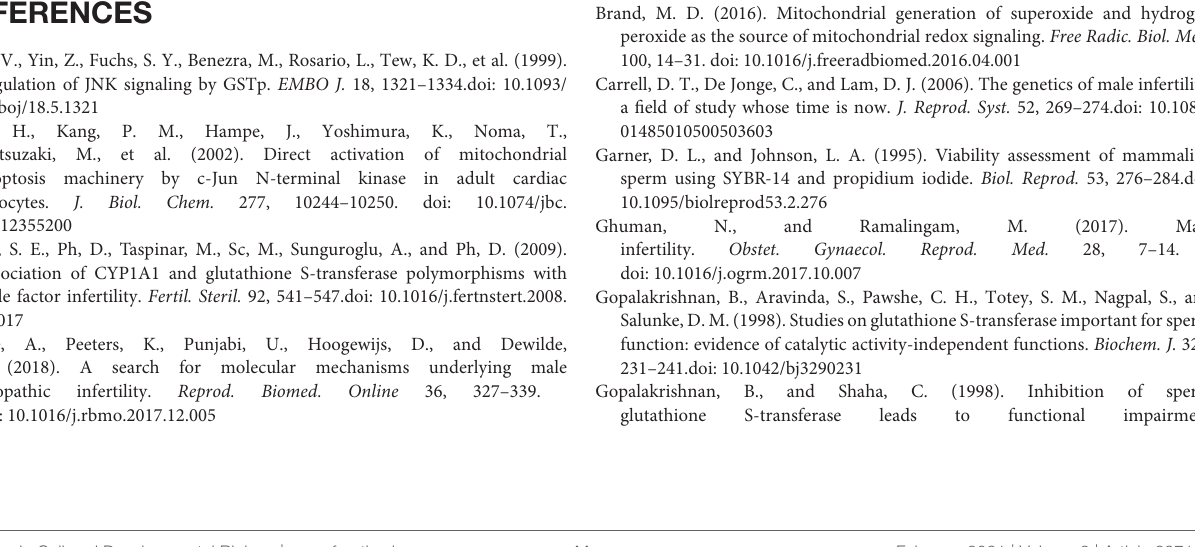
Supplementary Figure 1 | Preliminary concentration test. Mean and standard error of the mean (SEM) of the percentage of (A) viable sperm, (B) total motile sperm, (C) viable-membrane destabilized sperm,and (D) high mitochondrial membrane potential (high MMP) sperm. Different ezatiostat (TER) concentrations (10 µ M, 100 µ M, and 1000 µ M) were tested (TER 72h; light gray bars), and the same volume of DMSO was added to Control-72h samples as a vehicle control group (Control 72h; medium gray bars). Semen samples at 0 h of storage were also analyzed (Control 0h; dark gray bars). Sample size ( n = 3). ∗ p ≤ 0.05;